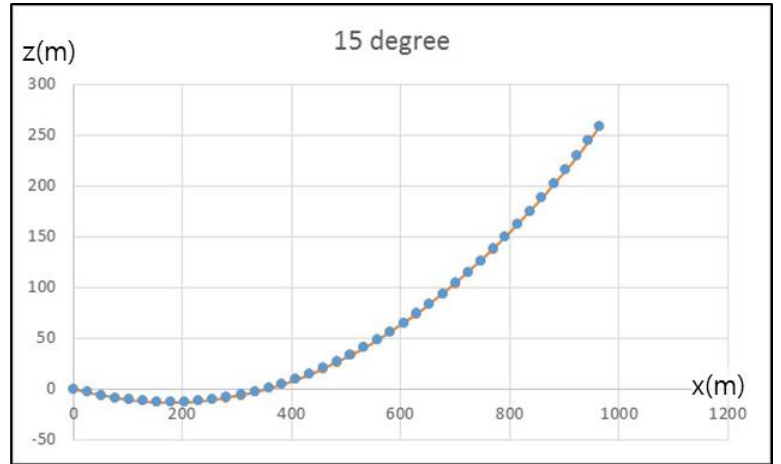
Figure 3. Numerical example of mooring line.